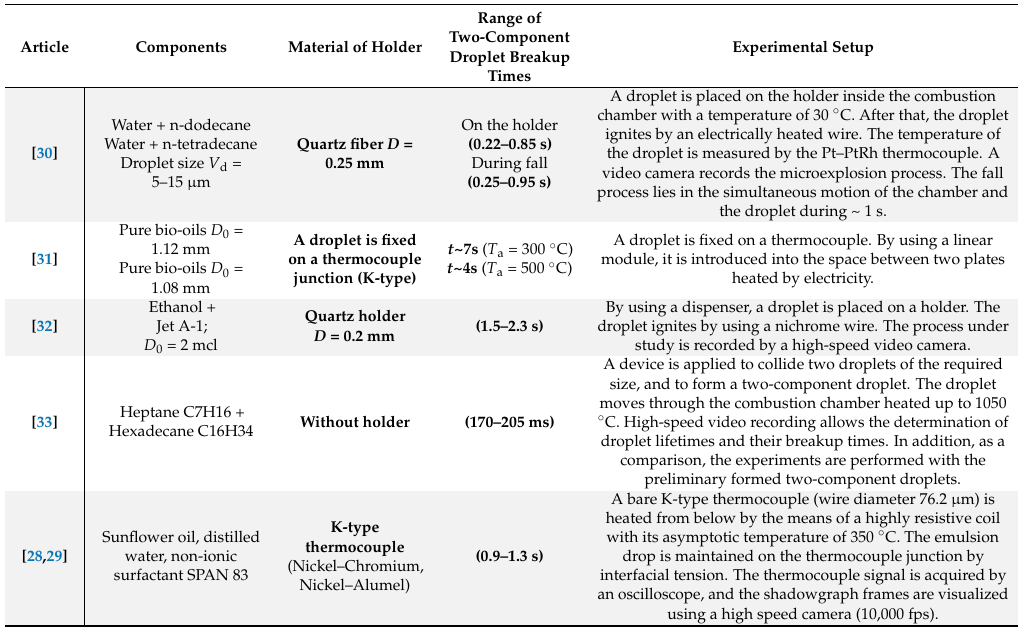
Table 1. Review of time ranges of droplet microexplosion established in the experiments accomplished by using different experimental